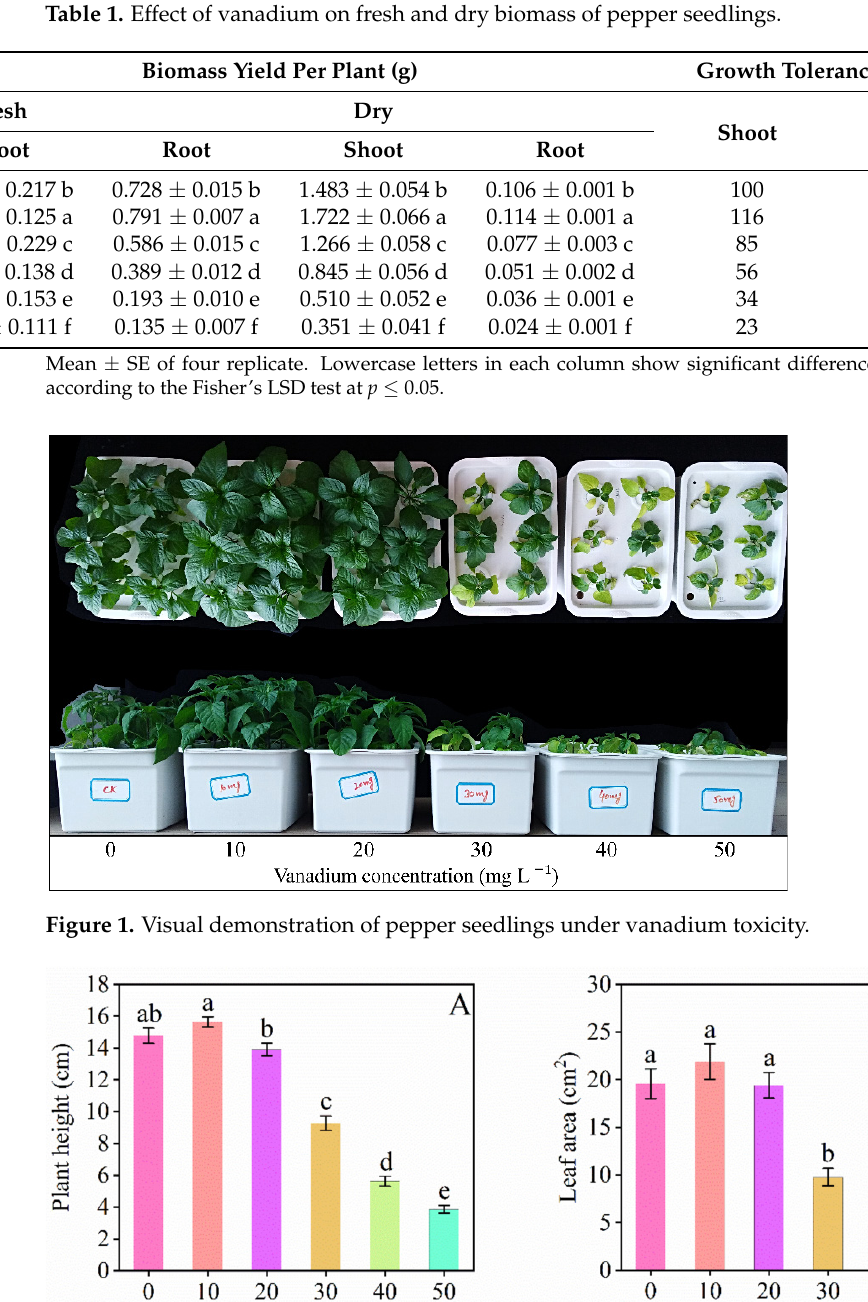
Table 1. Effect of vanadium on fresh and dry biomass of pepper seedlings.